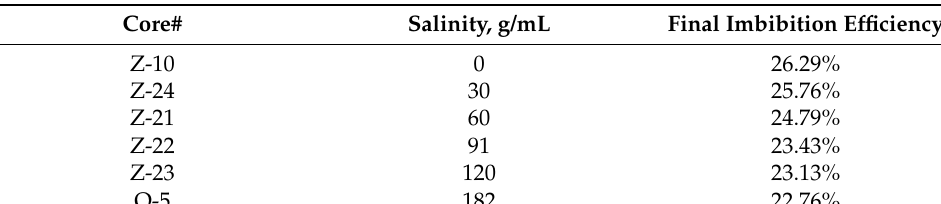
Table 3. Imbibition results for testing effects of salinity.